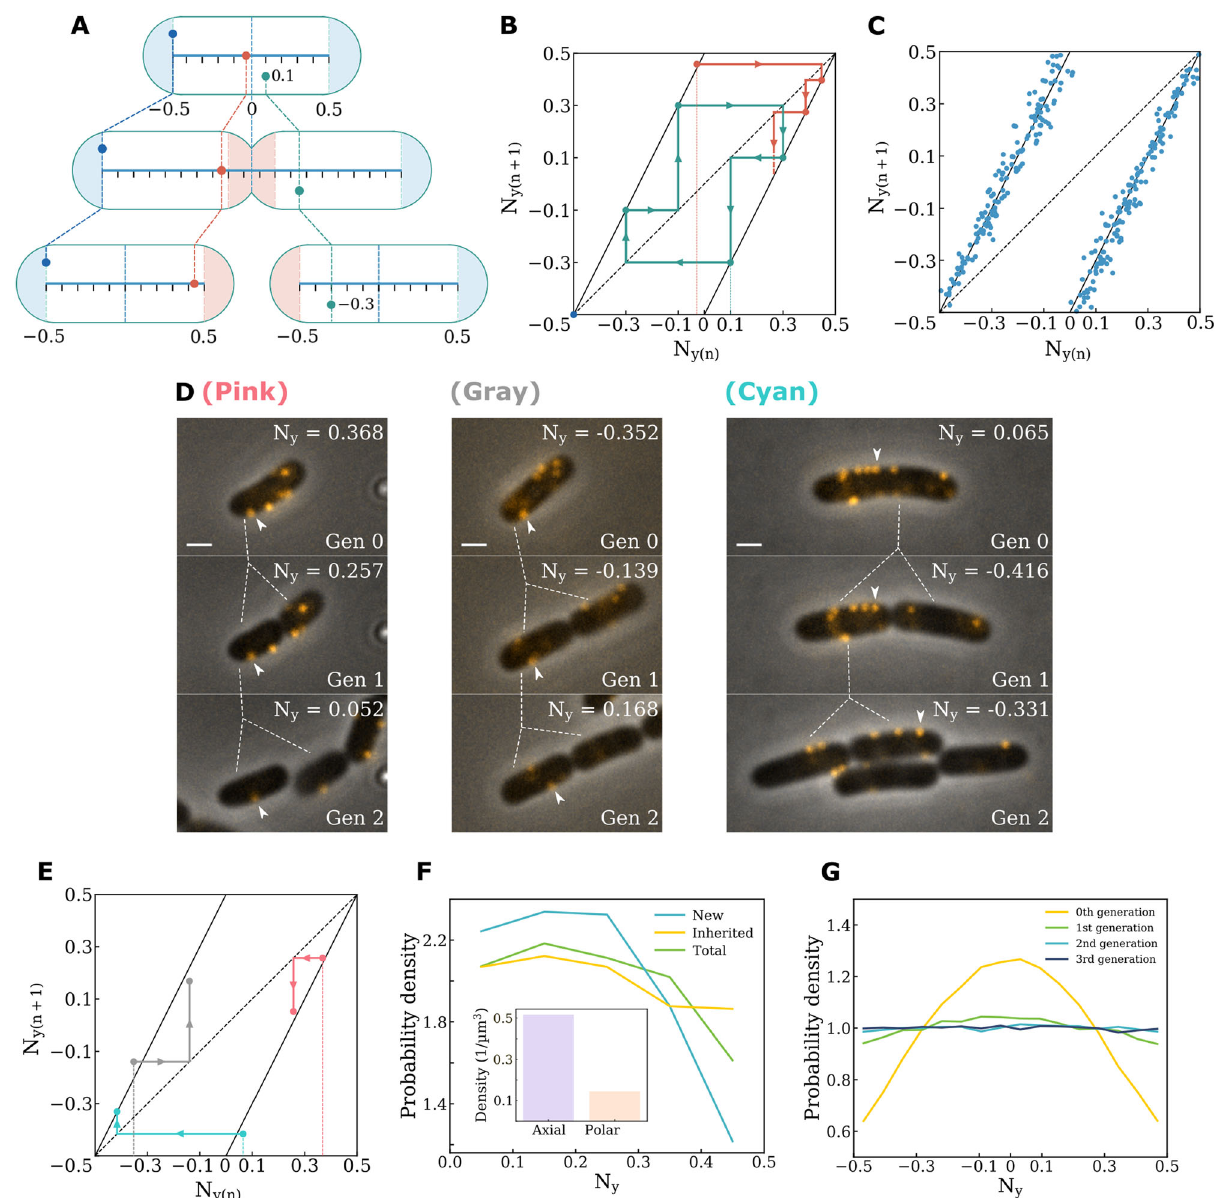
Fig. 4 Mathematical modeling of BFM positions after cell division. A A schematic of the Bernoulli shift map model for predicting the partitioning of BFMs across cell generations. Proteins anchored to the central rod region will follow the Bernoulli shift map. B Model prediction of the moving trajectories of BFM positions across cell generations on the Bernoulli shift map. N y(n) and N y(n + 1) are the normalized axial positions of a BFM in the n th and (n + 1) th generations. The dashed line is the guideline for N y(n) = N y(n + 1) . The black lines are the Bernoulli shift map. The red trajectory is a BFM starting from a position close to the center of the cell; in the next generation, it will move to the edge of the active zone. The green trajectory is a BFM starting from N y(1) = 0.1, and moving to N y(2) = − 0.3, then N y(3) = − 0.1, then N y(4) = 0.3, N y(5) = 0.1, completing a cycle. C Experimental tracking of BFM positions across two generations (one cell division) of a population of cells (n = 292 BFMs). The data points fell on the Bernoulli shift map. D Time-lapse imaging of three representative cases tracking the position of a BFM across three generations. The arrow labels the BFM that were tracked. (Scale bar, 1 μ m). E Moving trajectories of the three BFMs tracked in D . The data points fell on the Bernoulli shift map. F The experimental distribution of BFMs in the normalized coordinate along Ny. The green line shows the total BFM distribution by single-color labeling (n = 7757 BFMs), and the yellow and light blue lines show inherited (n = 1508 BFMs) and new (n = 1472 BFMs) BFM distribution by dual-color labeling. Inset: the average BFM density was higher in the axial area than in the polar area. G Simulation of BFM distribution evolution over 3 generations. The positions of 200,000 BFMs were assigned following a truncated Gaussian distribution ( σ = 0.4). This uneven distribution was smoothed quickly after one generation by the Bernoulli shift